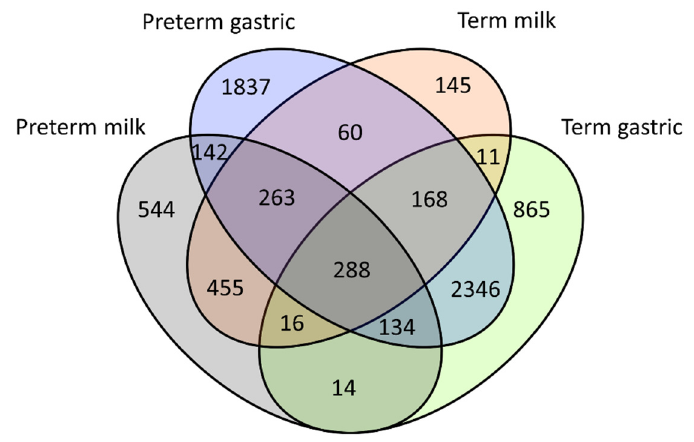
Figure 1. Venn diagram showing number of peptides identified in each sample group and their overlaps with other samples groups.